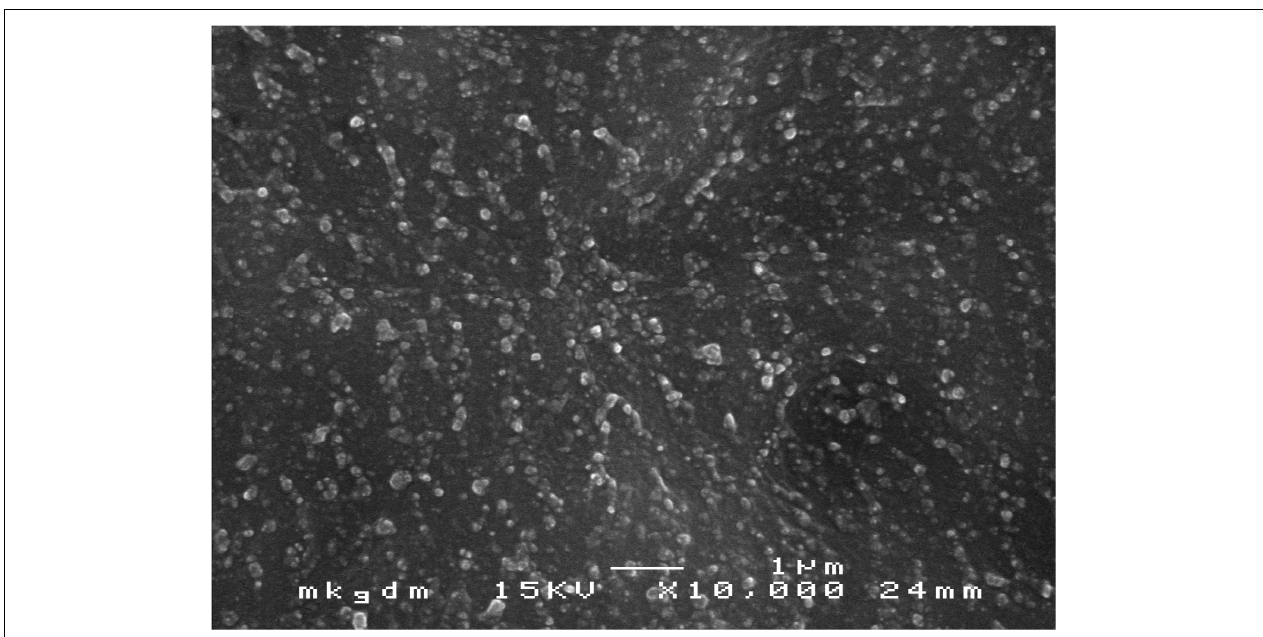
FIGURE 1 | Scanning electron microscopy (SEM) image of chitosan nanoparticles (CSNPs) loaded with amphotericin B (AMB), which were functionalized with β -1,3-glucanase (Gls) (CSNPs-AMB-Gls). Magnification, × 10,000.